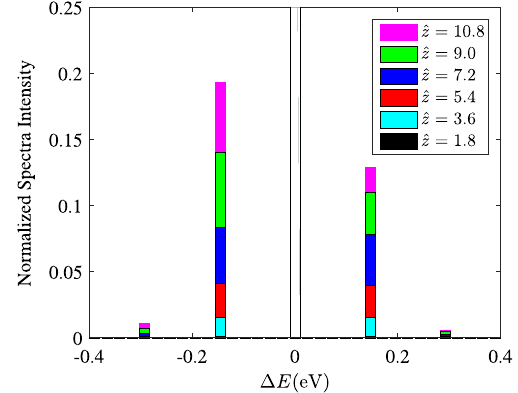
FIG. 2. Spectra along the undulator length to illustrate the growth of the sideband power. The spectra are normalized by the amplified seed intensity a 1 ð ˆ z Þ and the spectral unit is photon energy ( Δ E ¼ ℏ ω s ). The electron beam energy modulation wavelength is 8 μ m while the normalized modulation amplitude ˆ A ¼ 0 . 13 .